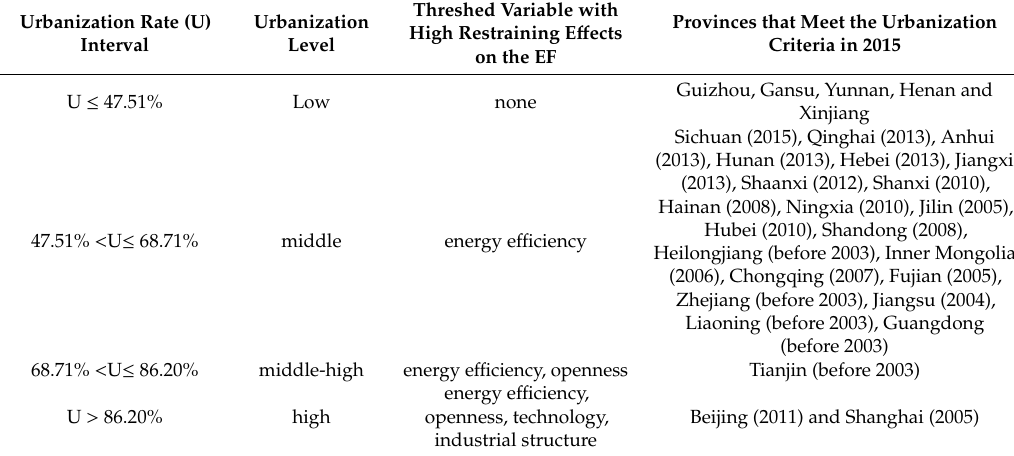
Table 9. Division of China’s 30 provinces by urbanization level of the threshold e ff